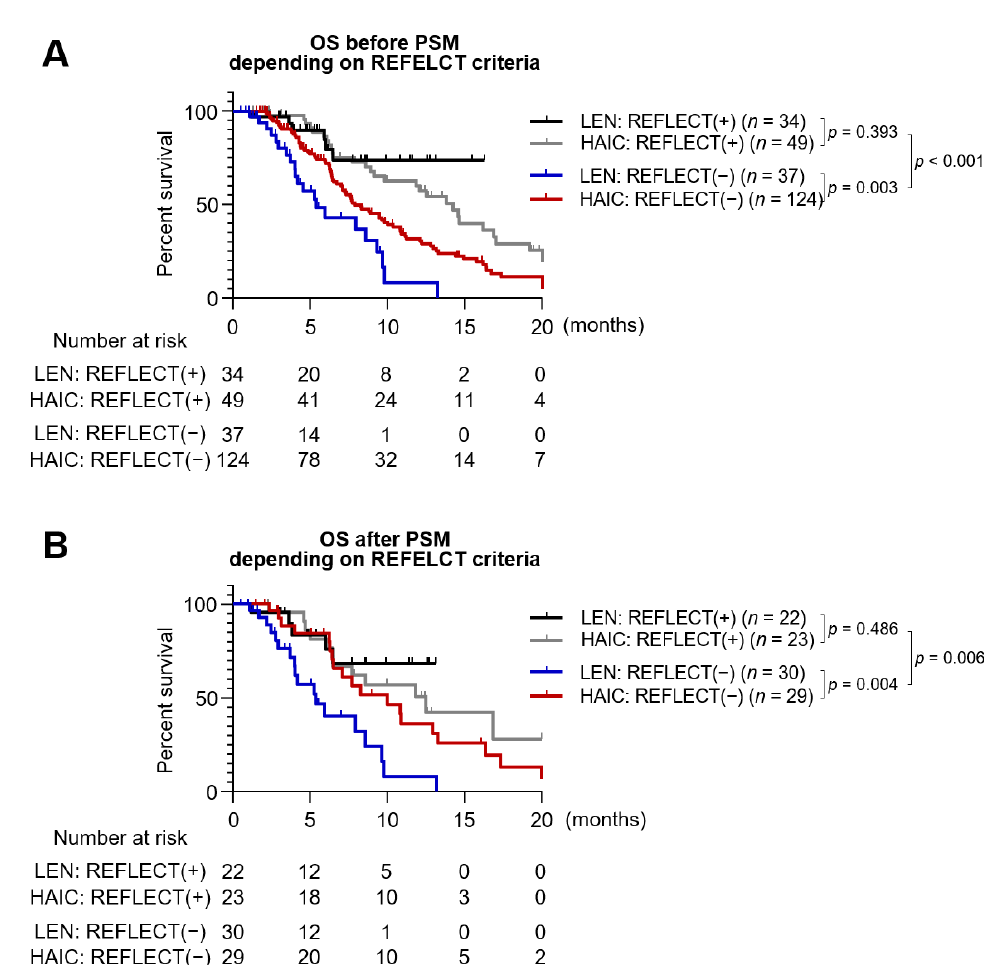
Figure 2. Kaplan–Meier survival curves analyzing OS according to the meeting the RELECT criteria and types of treatment. ( A ) OS in the entire cohort ( n = 244). ( B ) OS in the PSM cohort ( n = 104). REFLECT (+) means “meeting the REFLECT criteria”.